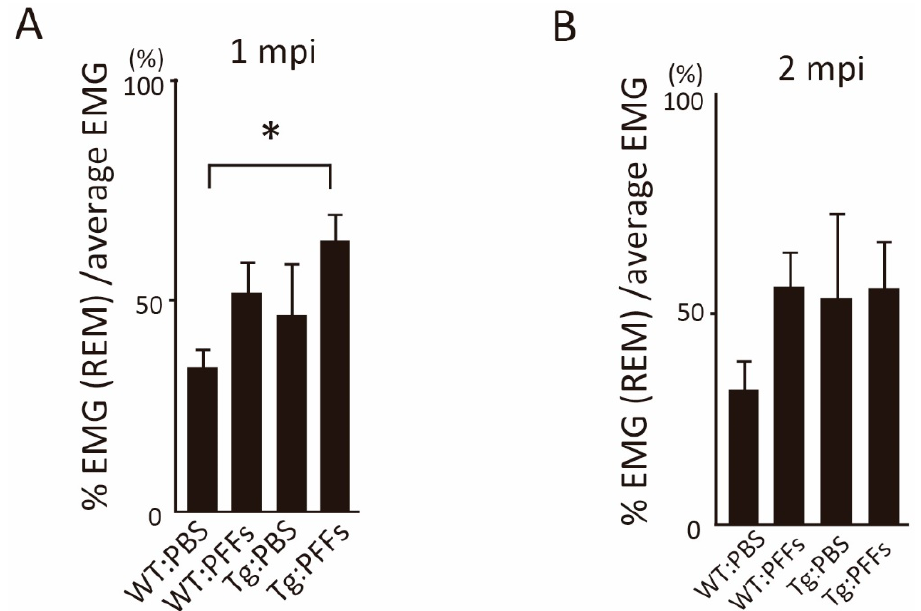
Figure 2. Intrastriatal α -syn PFFs inoculation aggravated the RWA phenotype in Tg:PFFs mice. ( A , B ) The percentage of the integral value of electromyography (EMG) per epoch of REM sleep stage relative to that of EMG in the total sleep stage at 1-month post inoculation (mpi) ( A ) or 2 mpi ( B ) among four groups of mice. Data were analyzed using a one-way ANOVA and multiple comparisons were analyzed with the Tukey–Kramer test ( n = 4 per group). Asterisks indicate significant difference. Bar indicates the S.D.